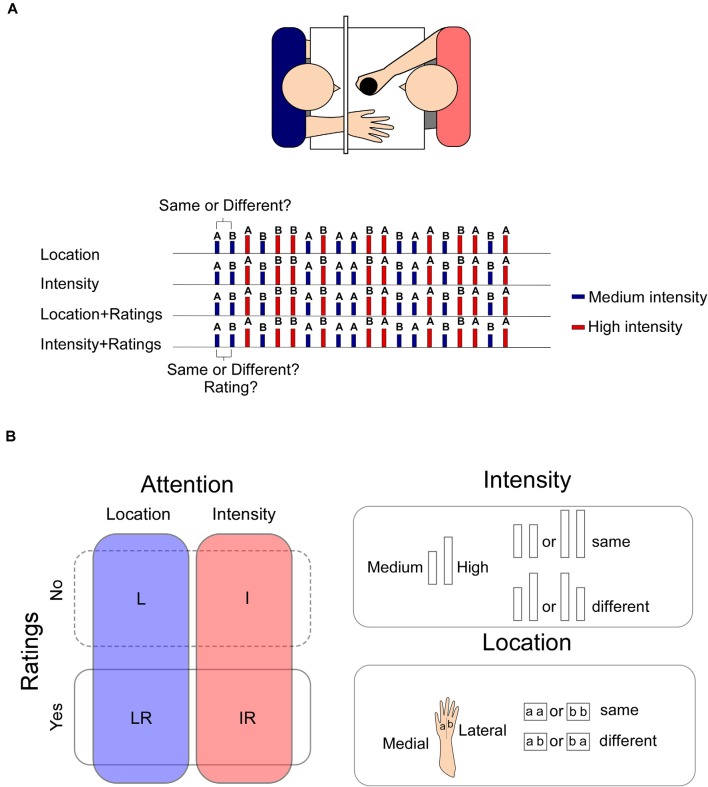
Panel (A) upper panel: the stimuli were applied manually on the participant’s right hand by one of the experimenters who was completely covered from view. The second experimenter collected the ratings and the responses. Lower panel: an example of the sequence of the stimuli. In LR and IR blocks, the response to the task was collected before the rating. Panel (B) left panel: the experiment was composed of four blocks in which participants had to focus either on changes in the location or on the intensity of the stimulus (blocks L and I). In two additional blocks, participants had also to provide a rating of the intensity of the stimulus (LR, IR). Stimuli could be of a High or a Medium intensity. Right panel: two intensities were used “High” or “Medium,” which were selected at the beginning of the experiment to elicit respectively a percept of 60/70 or 40/50 out of 100. Two consecutive high intensity or low intensity stimuli were considered “same.” Two consecutive stimuli of different intensities were considered “different” irrespective of the direction of the change (high-medium or medium-high). Two stimuli applied onto the same hand sector, whether medial or later were considered “same,” whereas two consecutive stimuli applied onto the later or medial sector of the hand were considered “different” irrespective of the direction of the change (lateral-medial or medial-lateral).